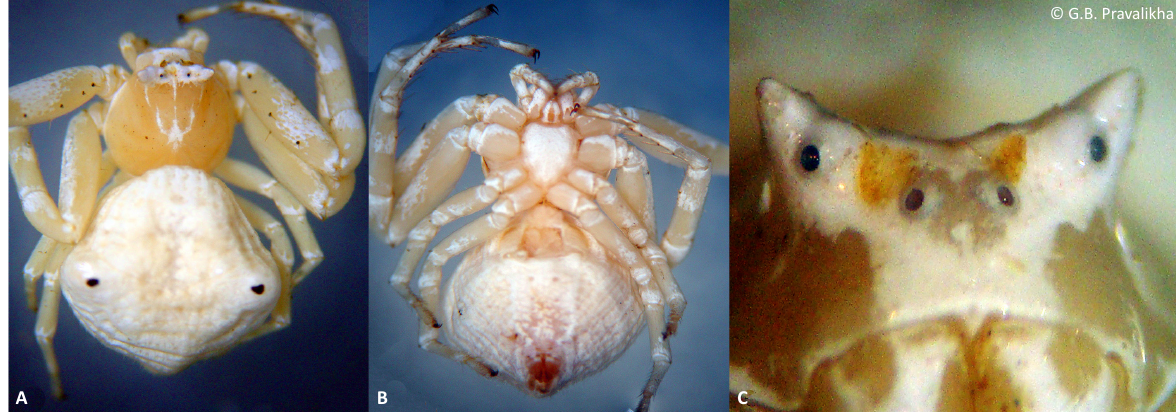
Abdomen: Wider than long 3.75 long, 4.04 wide. Pentagonal, slightly overlapping the posterior region of cephalothorax, broadest posteriorly, a pair of tubercles marked with a black spot, five sigillae present medially, four arranged in two pairs, posterior half with transverse muscular corrugations. Venter chalk white with muscular corrugation, three pairs of sigillae medially. Epigynum (Image 4A–B; Fig. 1A–B): Without sclerotized plate, a pair of deflated balloon-like spermathecae, with beak-like protuberances, intromittent canals short, winding back and going in the opposite direction of origin. Variations The paratype(OU.NHM.ART.ARA.2014.27) (Image